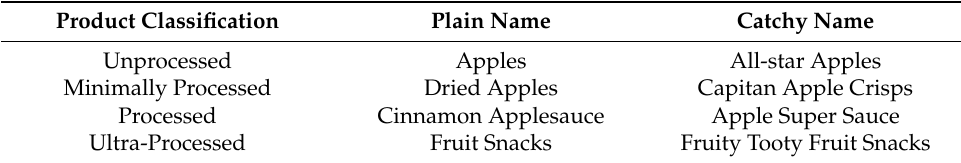
Table 4. Names used for labeling snack food options on the buffet